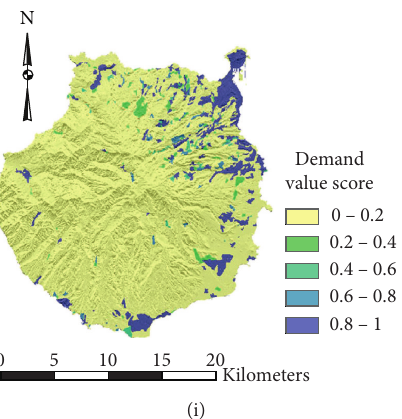
Figure 5: Factors: (a) wind speed, (b) solar radiation, (c) visual impact, (d) slope, (e) orientation, (f) territorial planning, (g) proximity to road access, (h) proximity to potential electricity self-consumption, and (i)